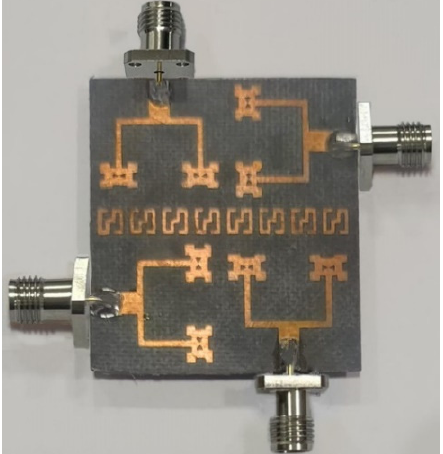
Figure 9. Fabricated antenna prototype.